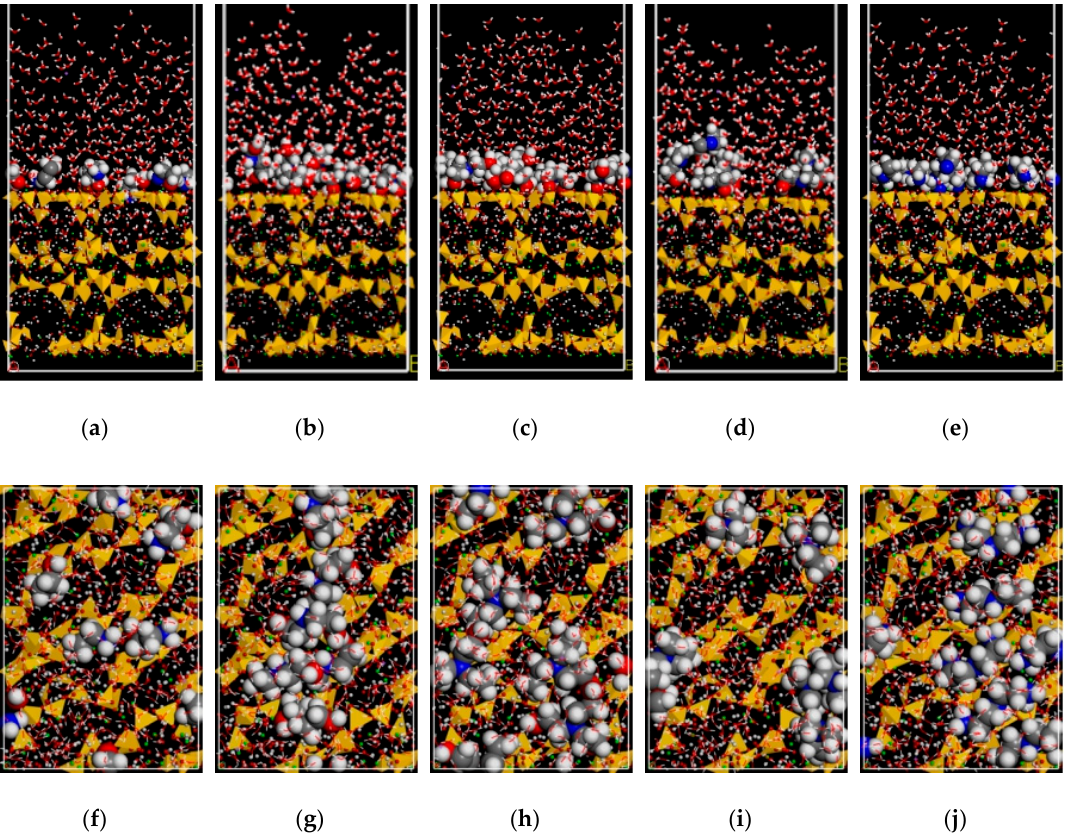
Figure 5. The final equilibrated snapshots (red ball: oxygen atom; green ball: calcium atom; white ball: hydrogen atom; yellow tetrahedral: silicate tetrahedral; violet ball: sodium atom; blue ball: nitrogen atom and grey ball: carbon atom): ( a ) main view of MEA; ( b ) main view of DEA; ( c ) main view of TEA; ( d ) main view of NDE; ( e ) main view of DETA; ( f ) top view of MEA; ( g ) top view of DEA; ( h ) top view of TEA; ( i ) top view of NDE and ( j ) top view of DETA.